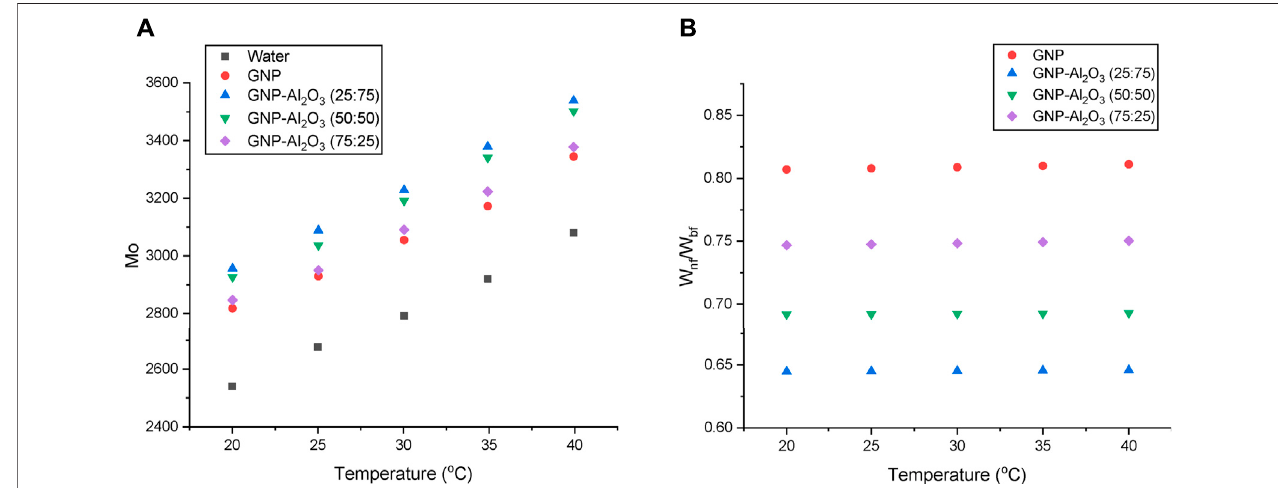
FIGURE 14 | (A) Mouromtseff number and (B) pumping power ratio of the GNP-alumina hybrid nano fl uids for different mixing ratios as a function of temperature.